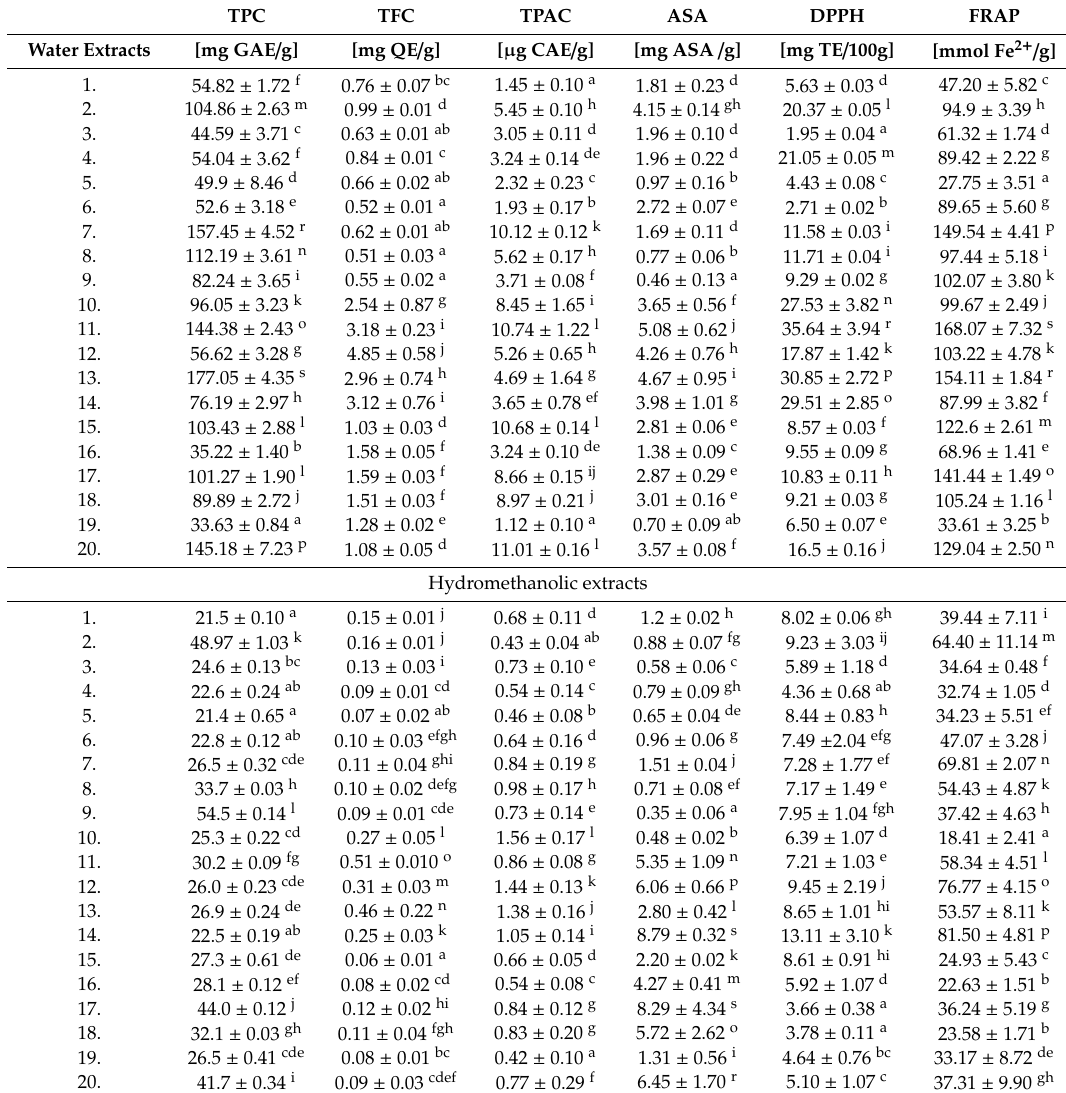
Table 1. Total phenolic (TPC), flavonoid (TFC), phenolic acid (TPAC), l ( + ) ascorbic acid (ASA) contents and DPPH and FRAP assays in the samples of Rosa canina